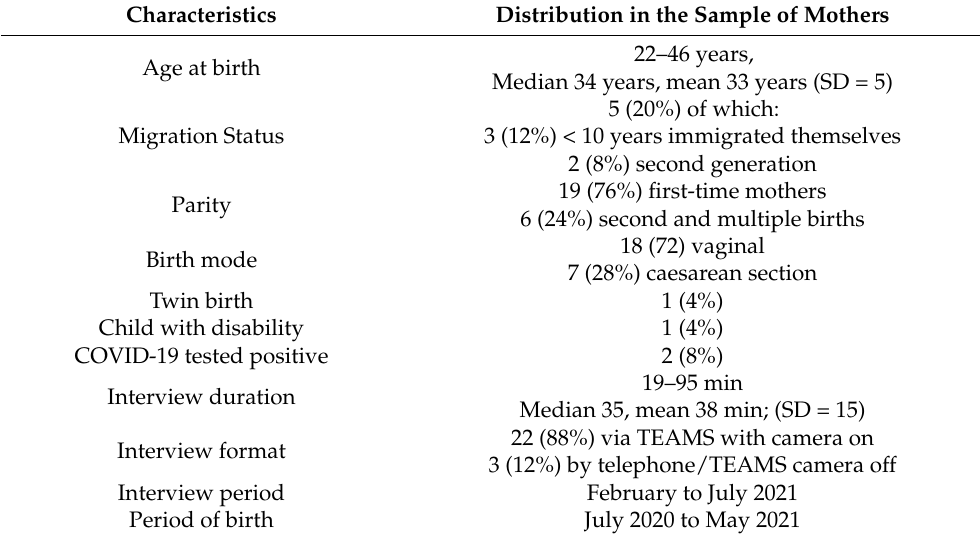
Table 1. Demographics of participating mothers *.